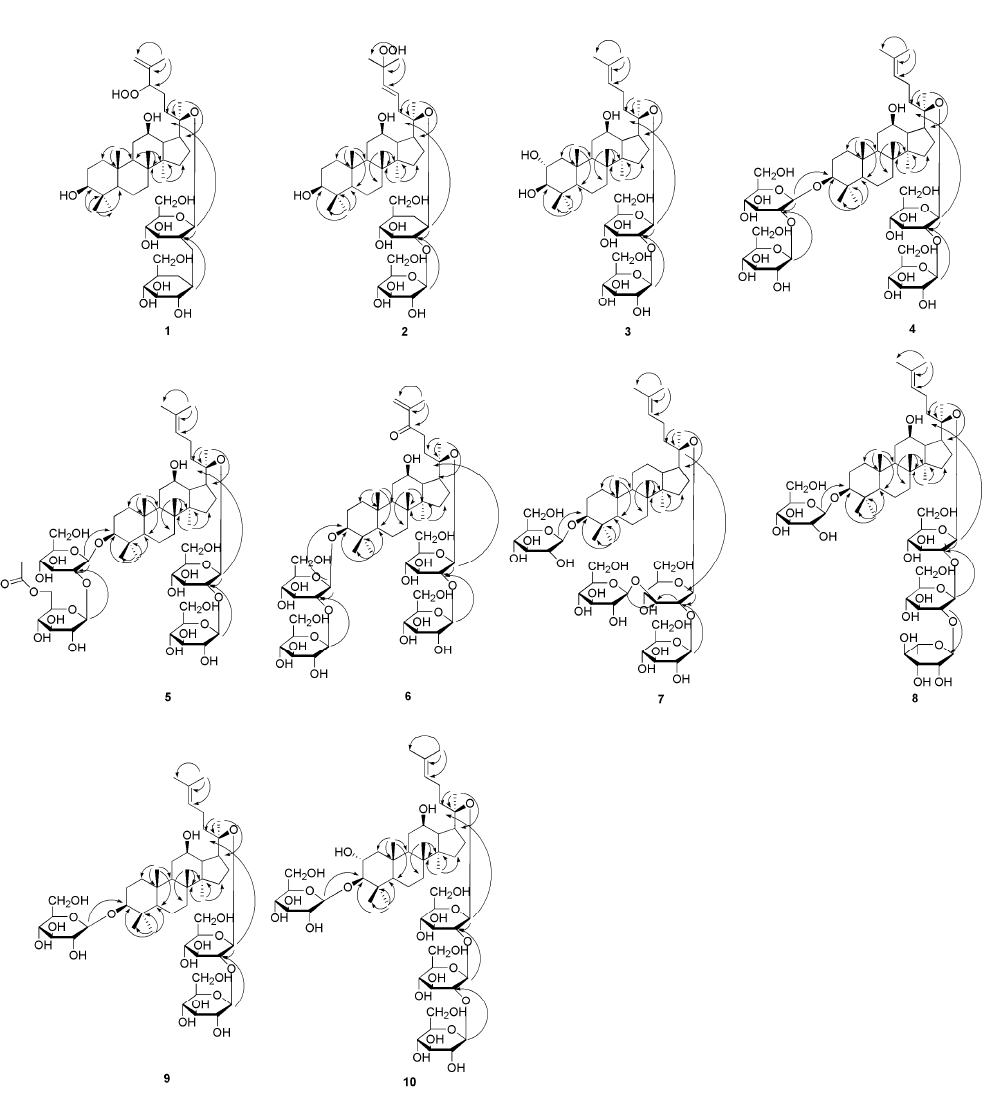
Figure 2. Key HMBC correlations of compounds 1 – 10 .